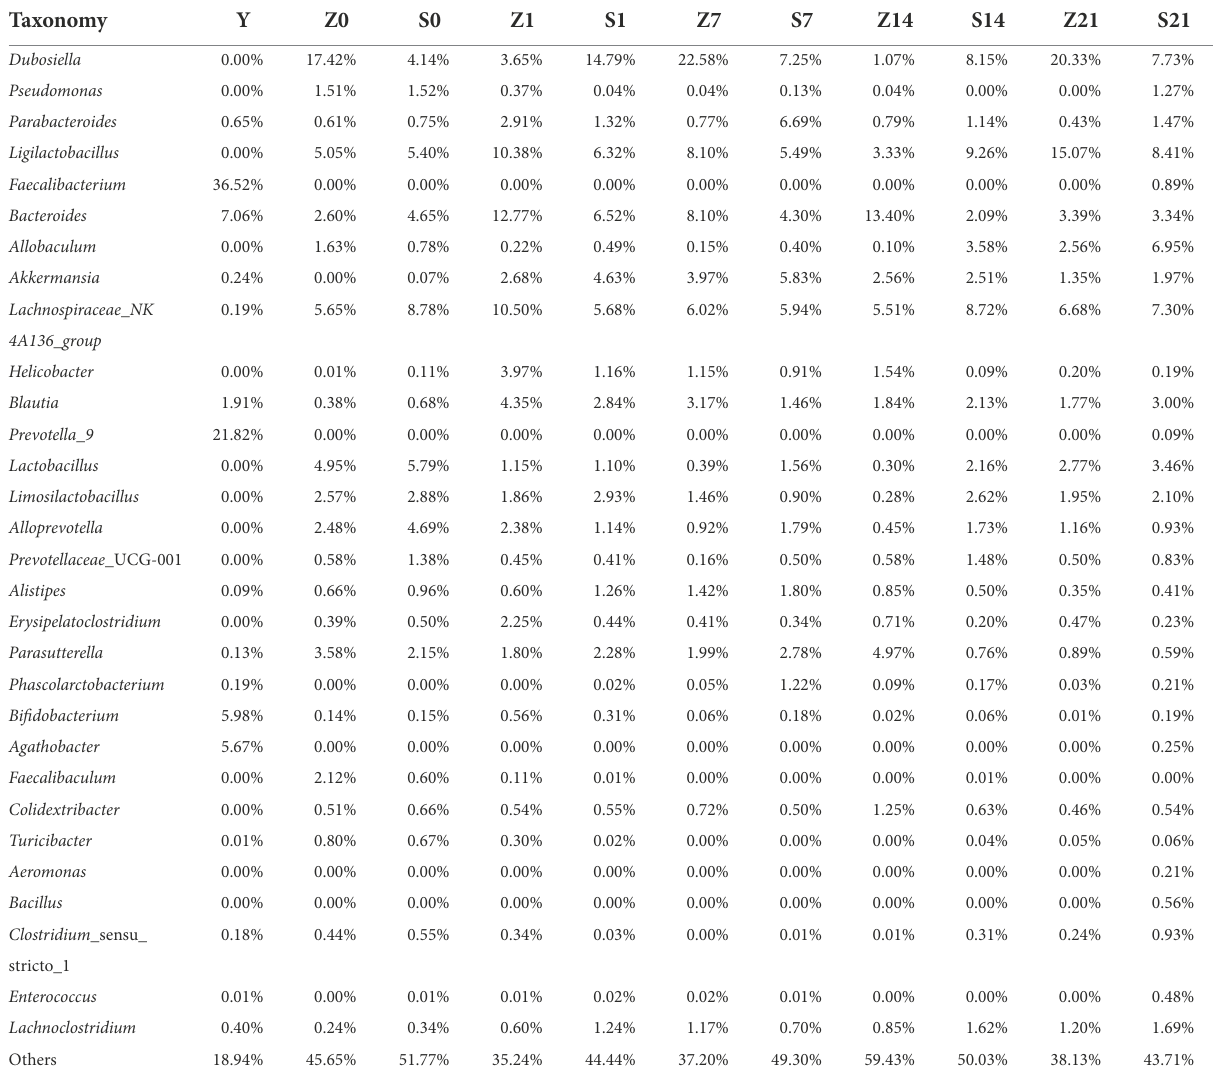
TABLE 2 Relative abundance of gut microbial composition at the genus level Top30 in specific pathogen free mice.